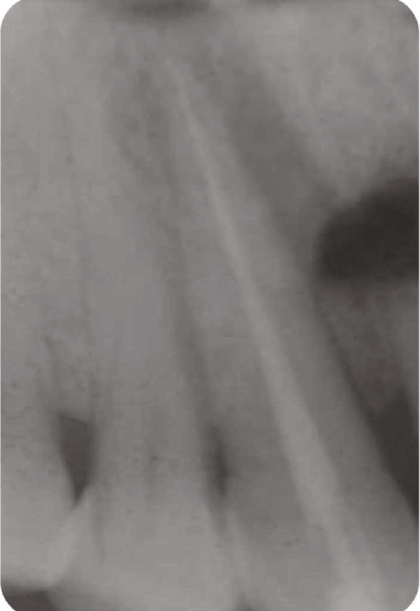
Figure 6: Two months ’ recall radiograph showing a continuous bone reorganization.